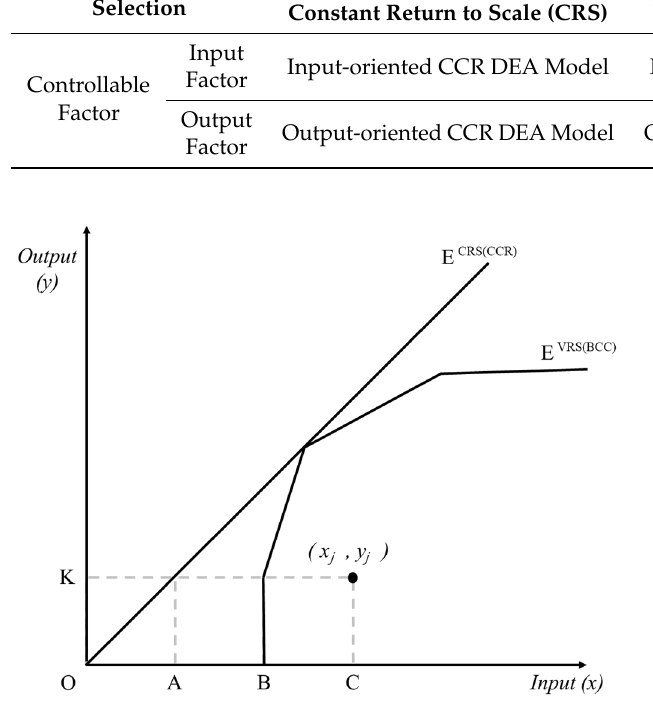
Figure 3. Frontiers of BCC and CCR models.